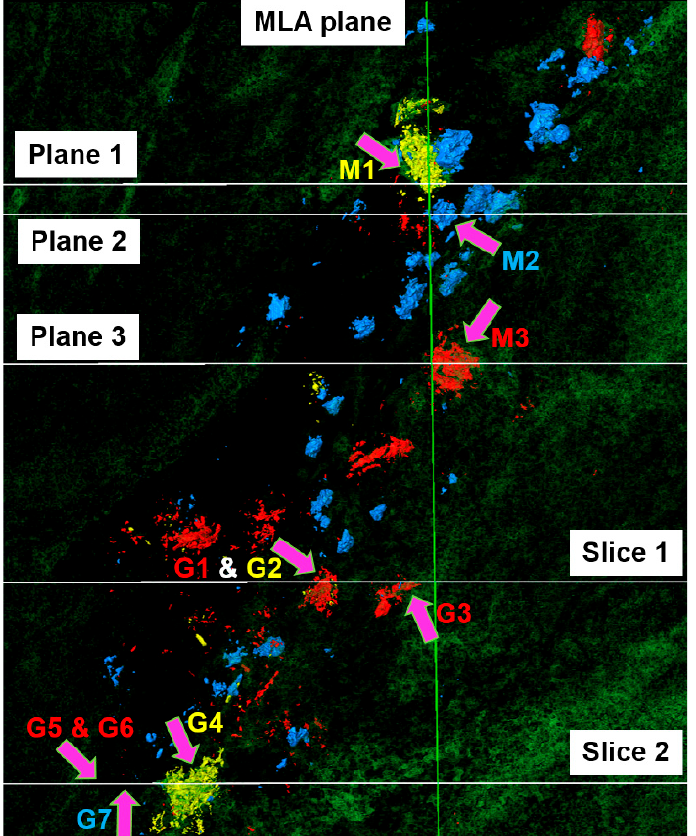
Figure A2. 3D volume of interest from the scanned field of view of experiment 2. The planes and slices scanned with the spectrum detector (white, horizontal) as analysed in Figures 4 and 5, the vertical cut that was analysed by MLA (green line), as well as the grains of interest indicated by pink arrows (M, identifies grains studied by MLA and Sp-CT, and G, identifies grains studied only by Sp-CT). Light phases (e.g., silicates) are set transparent, green are light sulphides (e.g., pyrite), yellow are very bright voxels (mostly gold), red voxels have the second brightest intensity range (mostly Pb sulphides), blue voxels have the third brightest intensity range (mostly Sb and As sul- phides).